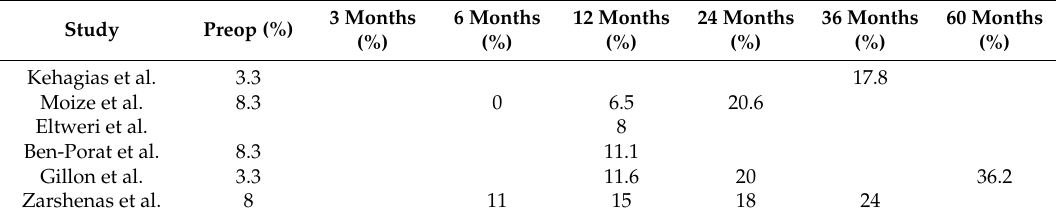
3 Months 6 Months 12 Months 24 Months 36 Months 60 Months (%) (%) (%) (%) (%) (%)